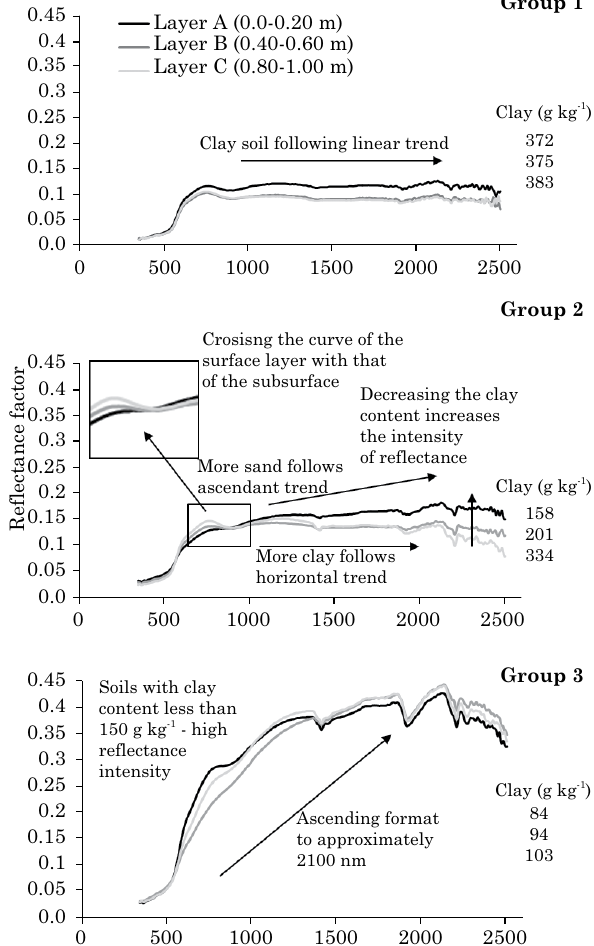
figure 4. Clustering of soil samples as a function of the form of spectral curves. Group 1 - clayey soils, low reflectance; Group 2 - soils with difference of reflectance between the surface and subsurface layers, typical of horizon with Bt; Group 3 - sandy soil characteristics, high